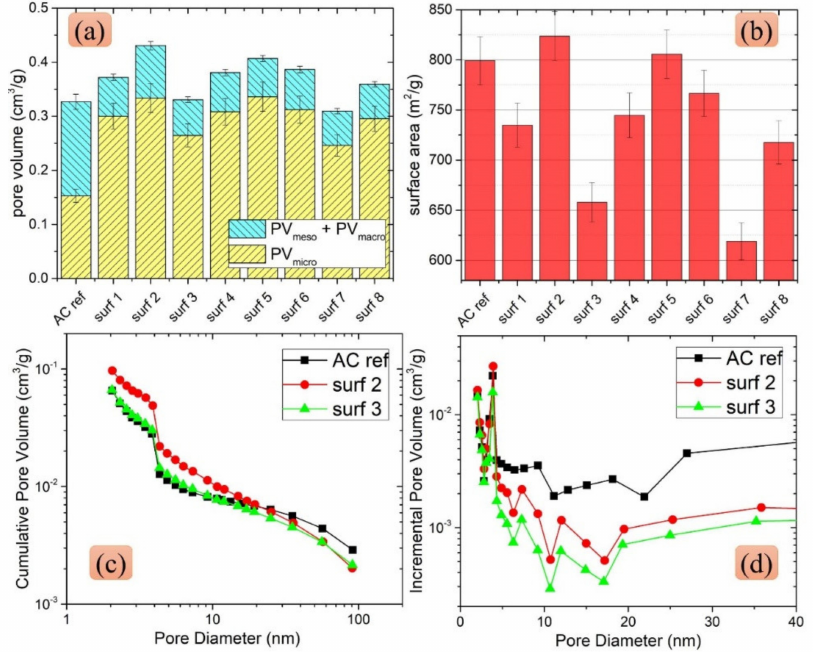
Figure 3. ( a ) Stack column plots of PV micro and PV meso + PV macro and ( b ) surface area of raw and surfactant-modified regenerated AC; representative ( c ) cumulative and ( d ) incremental pore volumes of the BJH desorption pore distributions of raw, surf 2, and surf 3